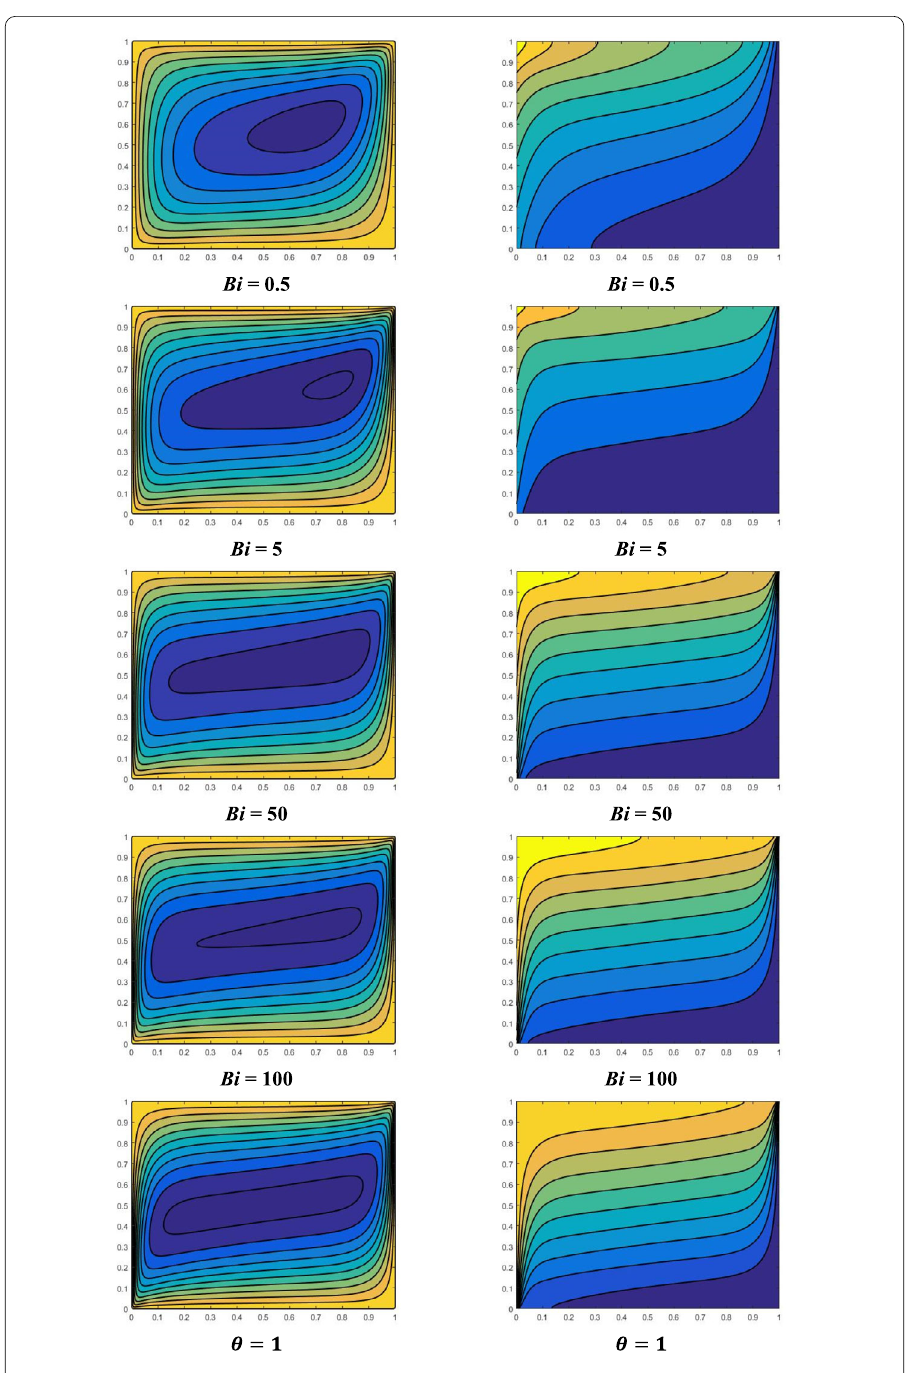
Figure 5 Streamlines (first column) and isotherms (second column), Ra =